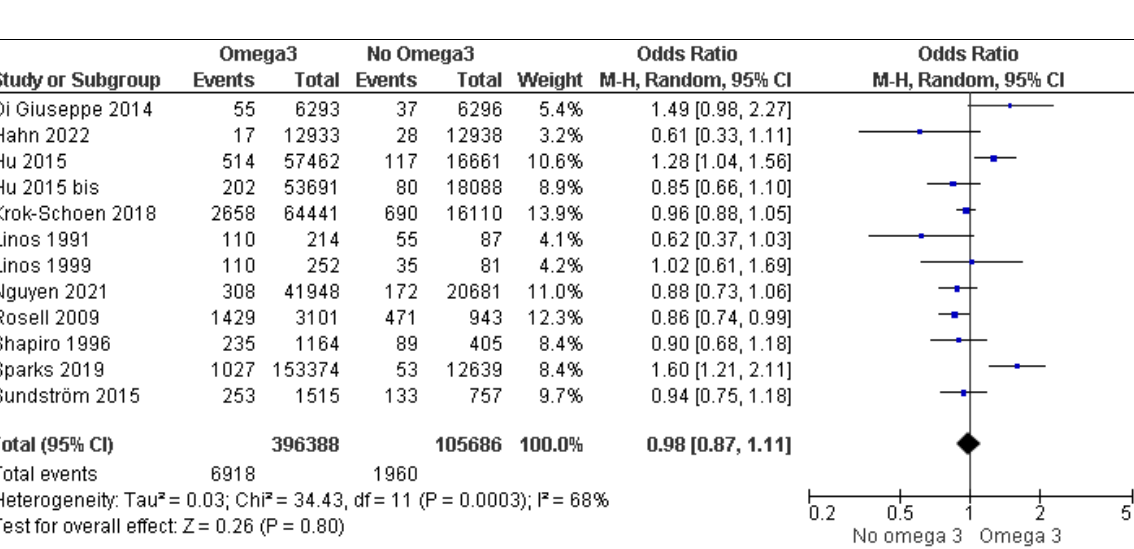
Figure 1. Flowchart of study selection.